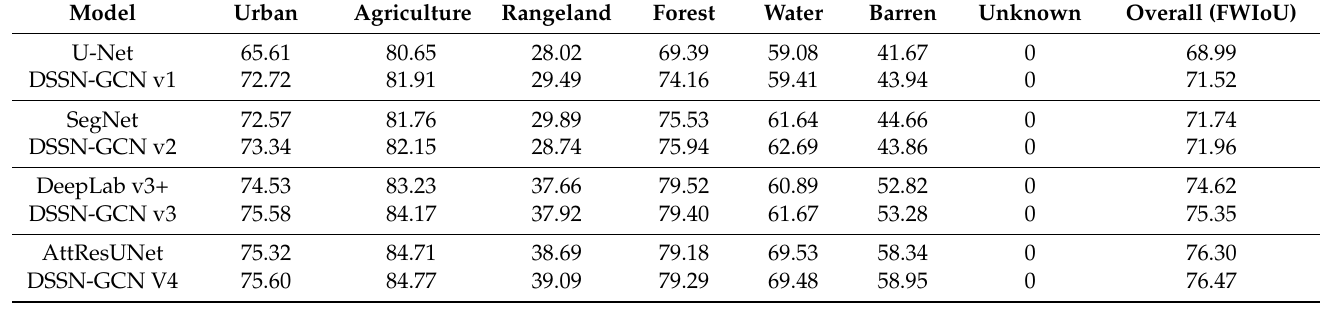
Table 7. The IoU (%) of semantic segmentation on the DeepGlobe dataset.